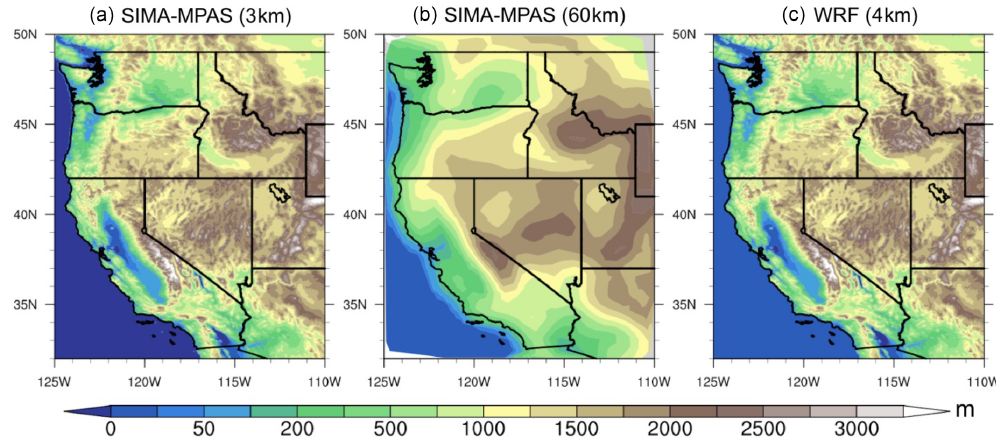
Figure 2. Topography over the western US region. (a) SIMA-MPAS at 3km refinement; (b) SIMA-MPAS uniform 60km grid mesh; (c) WRF simulations at 4km over